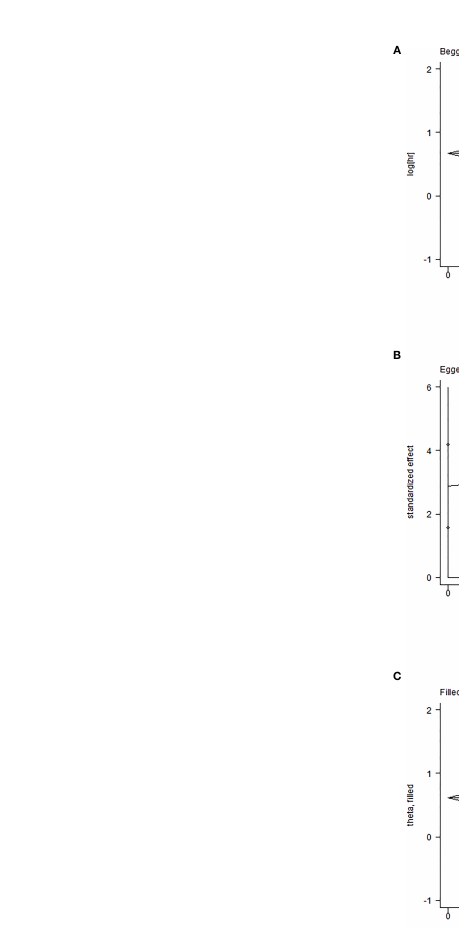
FIGURE 4 Plots for publication bias test in meta-analysis for overall survival. (A) Begg ’ s funnel plot; (B) Egger ’ s publication bias plot; (C) The trim-and- fi ll